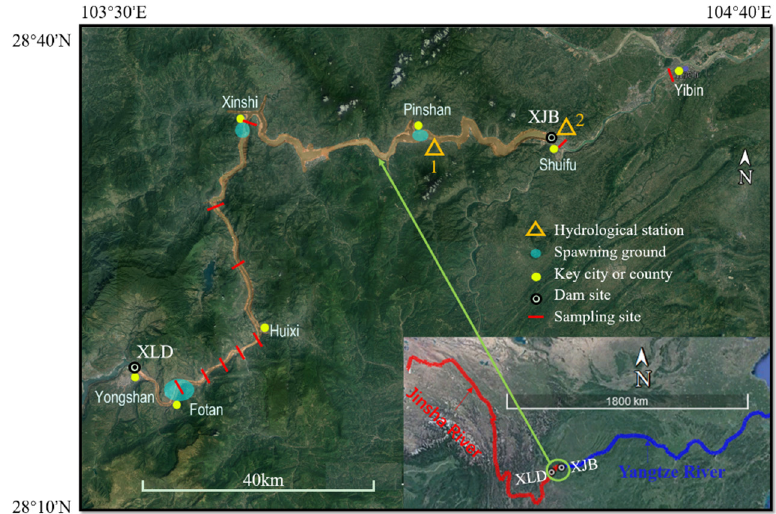
Figure A1. Spawning survey and spawning ground distribution of C. guichenoti between Xiluodu (XLD) and Xiangjiaba (XJB) dam.